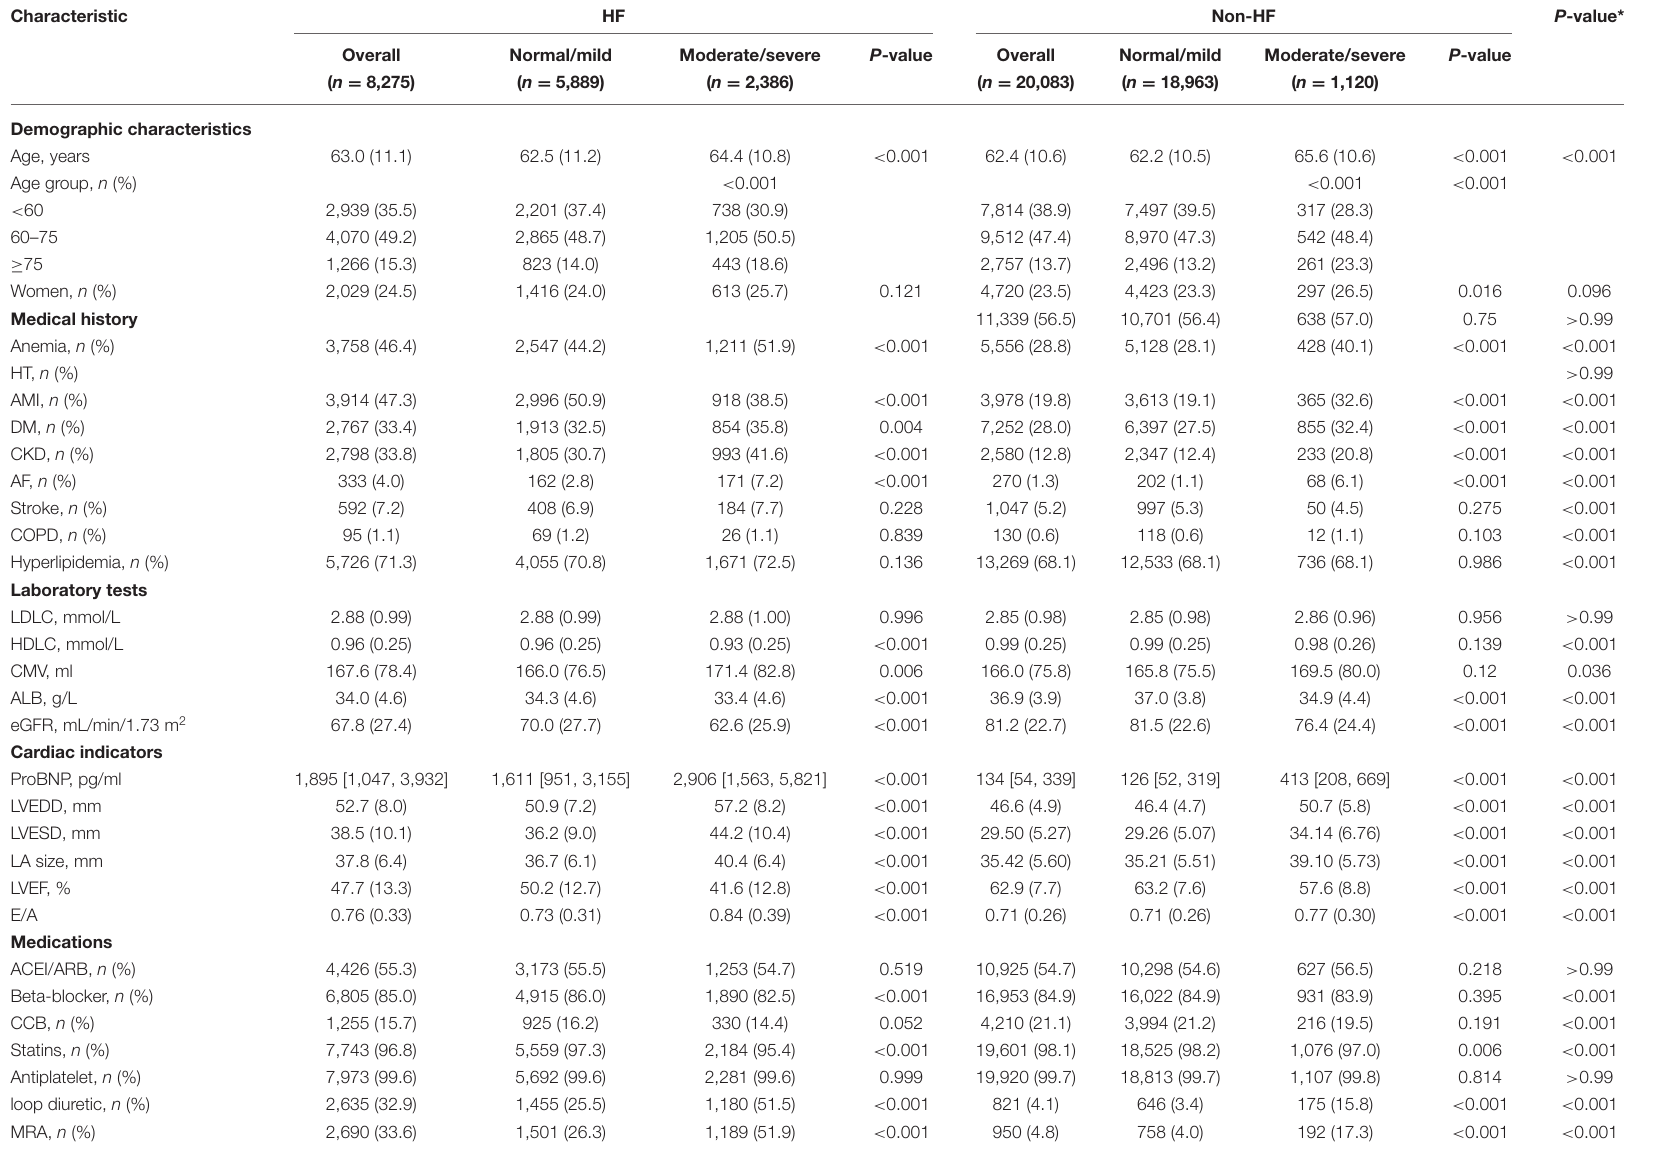
TABLE 1 | Baseline characteristics of the patients undergoing percutaneous coronary intervention (PCI) with different levels of mitral regurgitation severity stratified by heart failure (HF).